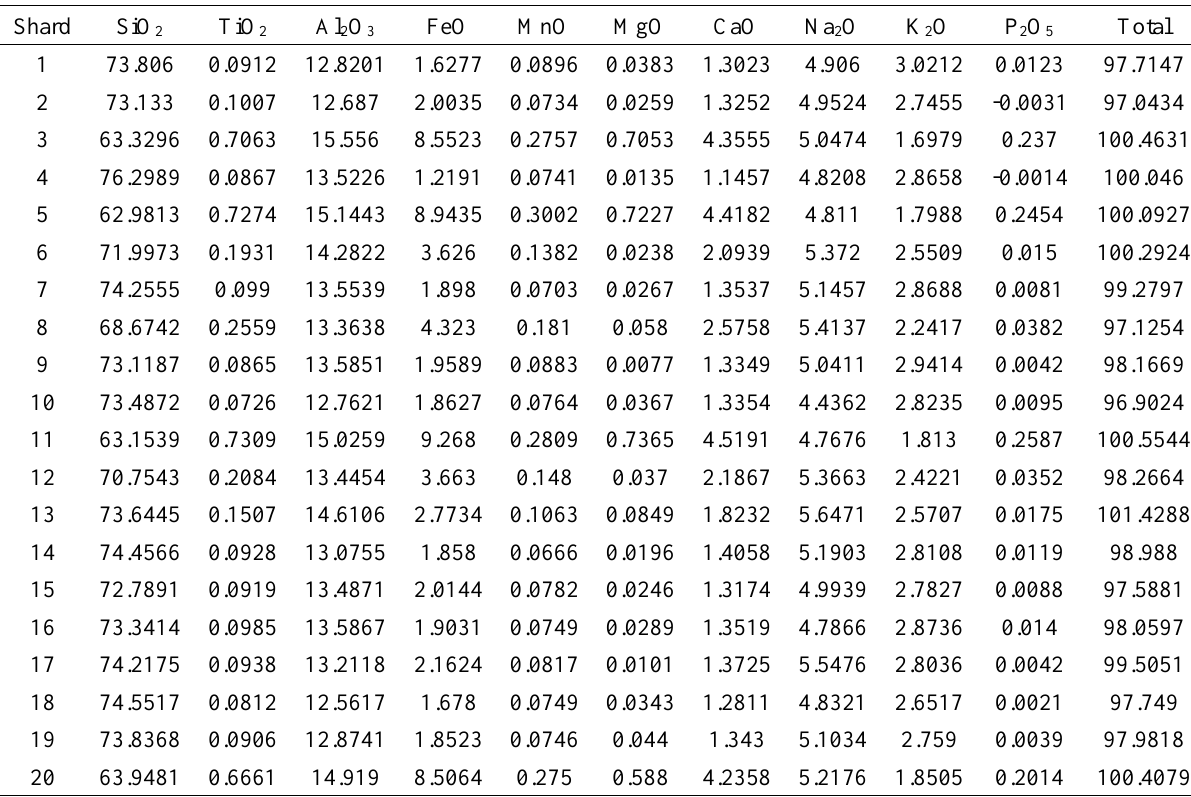
Table A4. Geochemistry from electronmicroprobe analysis of tephra shards found in the Bad a’ Cheo Forest core at 114 cm, identified as Hekla 4.